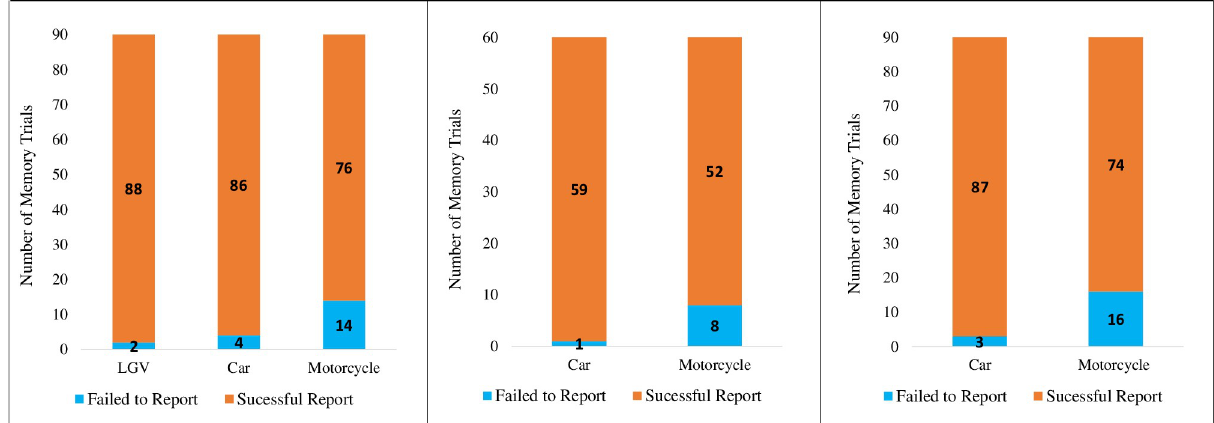
Fig 1. The number of occasions drivers failed to report a vehicle and successfully reported a vehicle (A) in Study 1, (B) in Study 2 and (C) in Study 3.